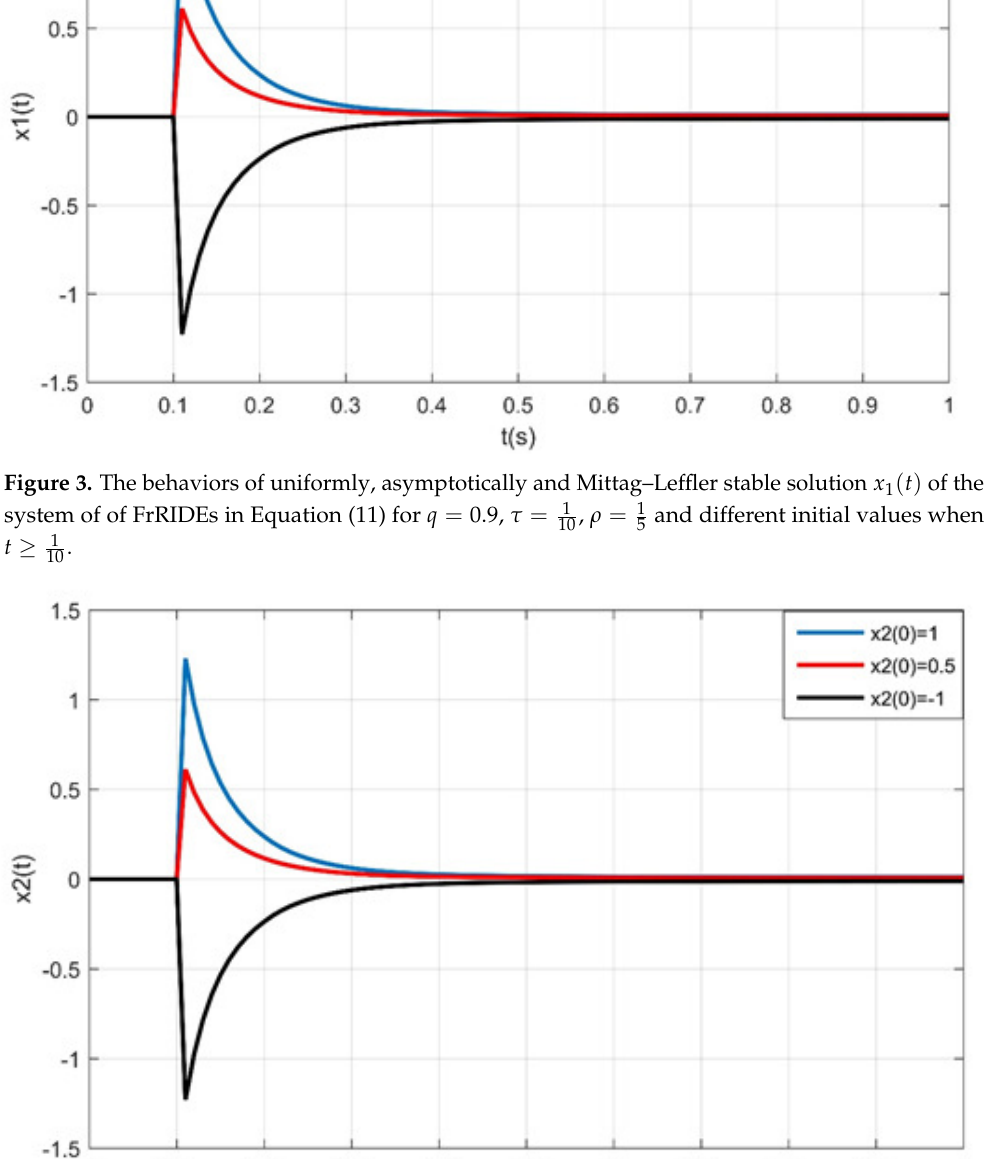
Figure 4. The behaviors of uniformly, asymptotically and Mittag–Leffler stable solution x 2 ( t ) of the system of of FrRIDEs in Equation (11) for q = 0.9, τ = 1 different initial values when t ≥ 1